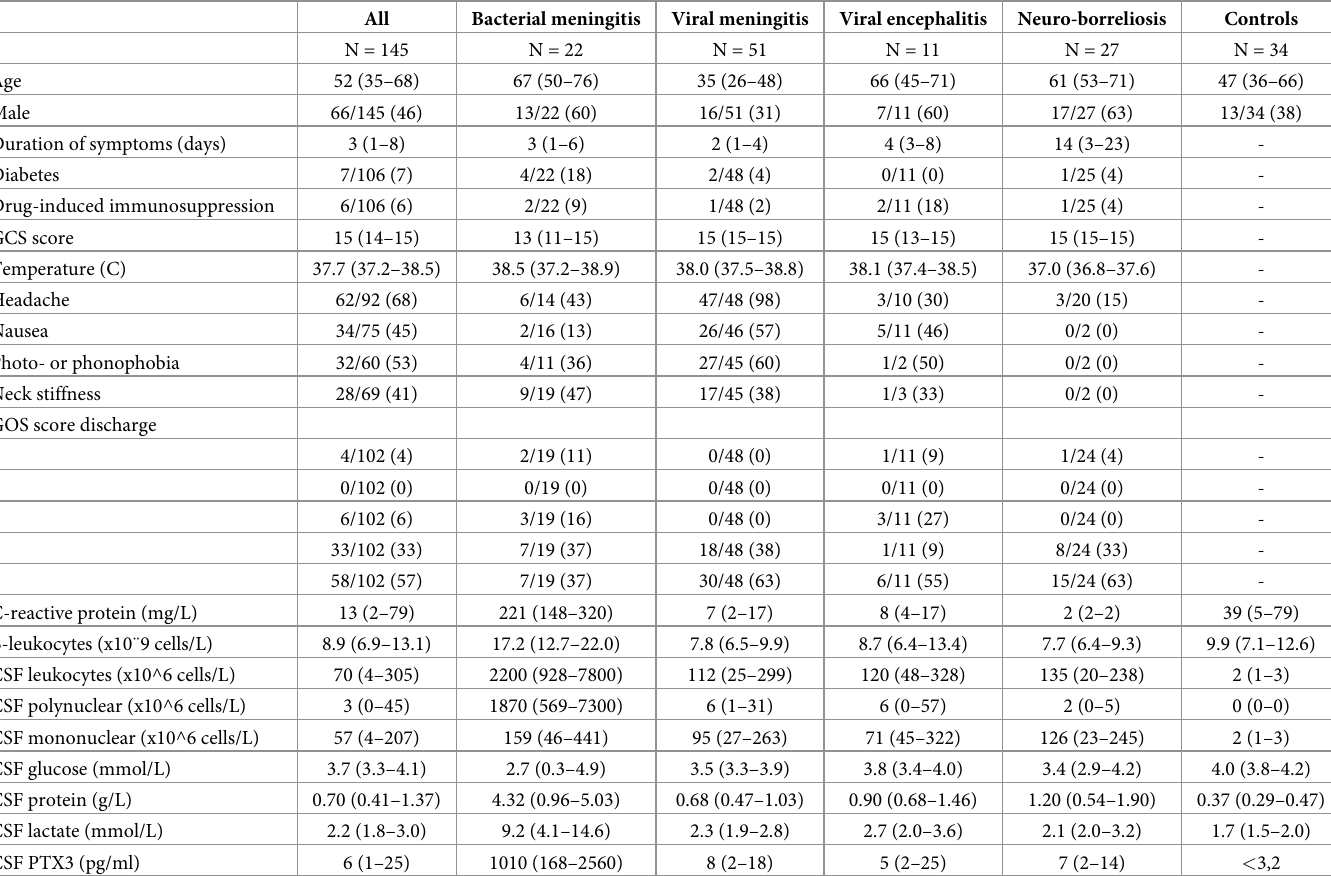
Table 1. Baseline characteristics of CNS infections with known